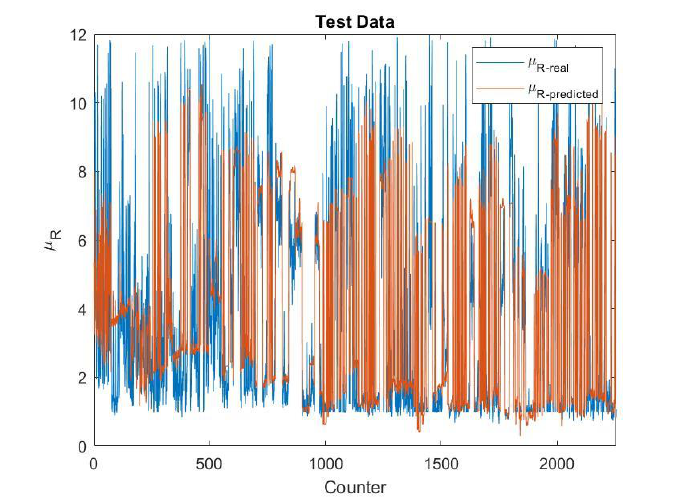
Figure 13. Comparison between the real and predicted value of ( μ R ) in testing data (Subtractive clustering